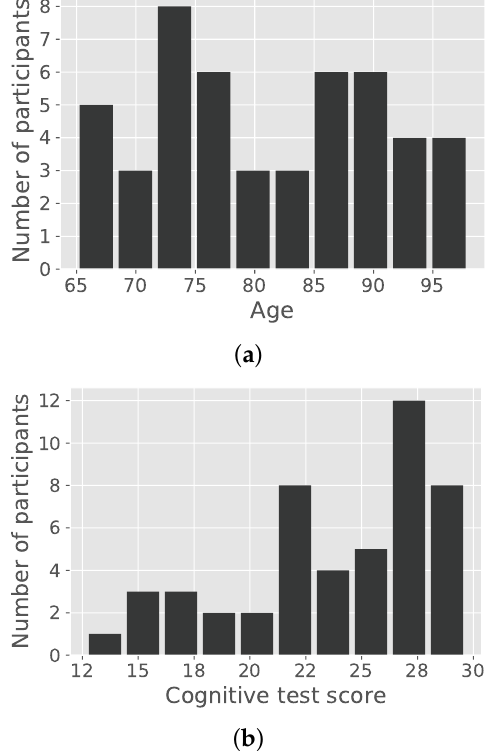
Figure 2. In ( a ), the age distribution of the participants is depicted. It closely follows a uniform distribution. In ( b ), the score of the cognitive test is depicted.